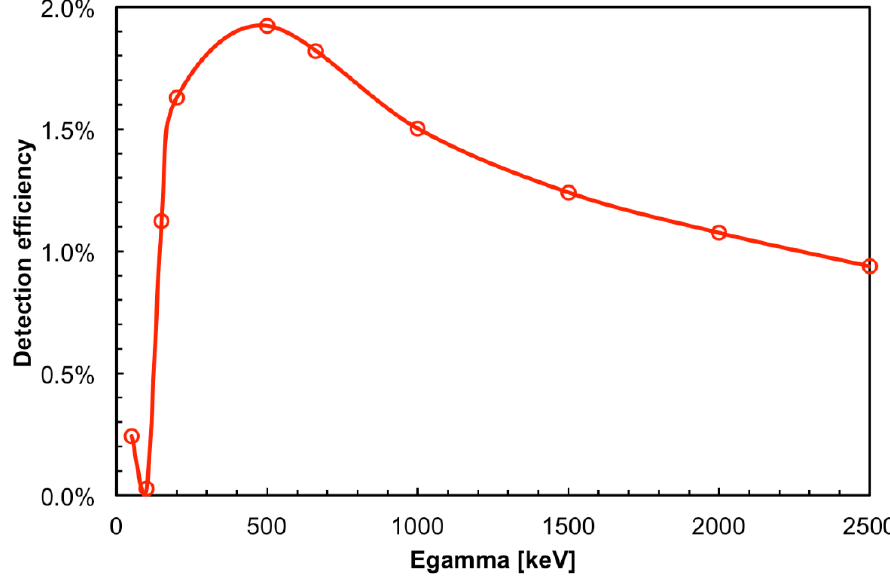
Figure 3. Simulation of the intrinsic detection efficiency of a 3 mm diameter fiber for several values of the impinging gamma-ray energy (threshold at 50 keV). The lines are spline interpolations.